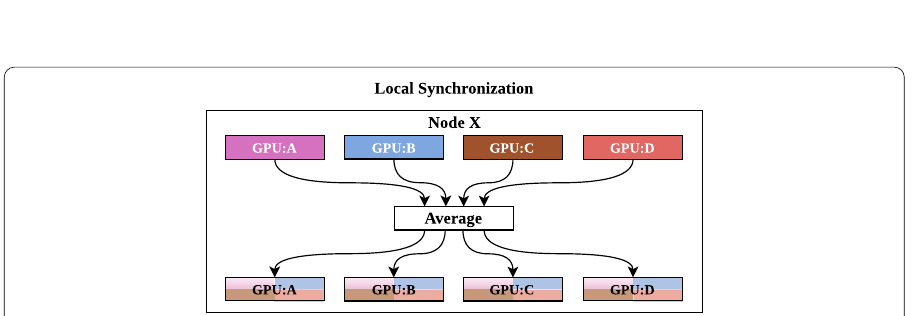
Fig. 2 Local synchronization Schematic of the local synchronization step for a single node with four GPUs. The gradients from each GPU are averaged, then each GPU’s gradients are set to the result